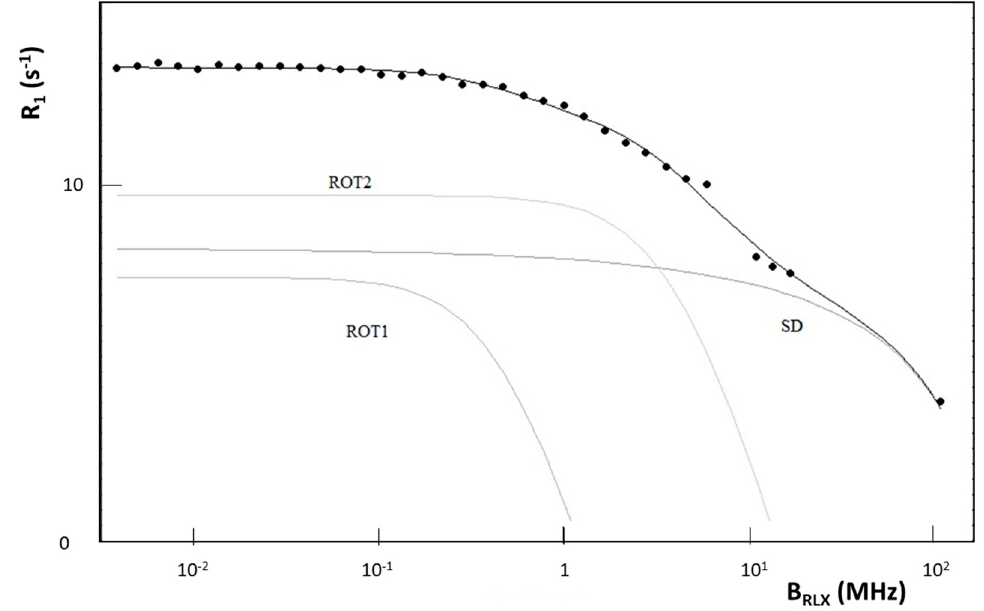
Figure 9. Frequency (MHz) dependence of proton spin-lattice relaxation rate, R 1 (s − 1 ) of 9/2 RS/RS at T = 377 K, on a Logarithmic scale, in the high-temperature isotropic phase. The black curve represents the best fitting curve of the R 1 -dispersion by using Equation (4) with two rotational processes ( ROT1 and ROT2 ) described by the BBP model (Equation (5)) and the self-diffusion (SD) process (Equation (6)). Fitting data are reported in Table 2. Table 2. Values of T 1 (s) at different frequencies (B RLX ) and relevant best fitting parameters of the 1 H NMR R 1 —dispersions for the two samples L1 and 9/2 RS/RS in the isotropic phase, as obtained by using Equations (4)–(6).